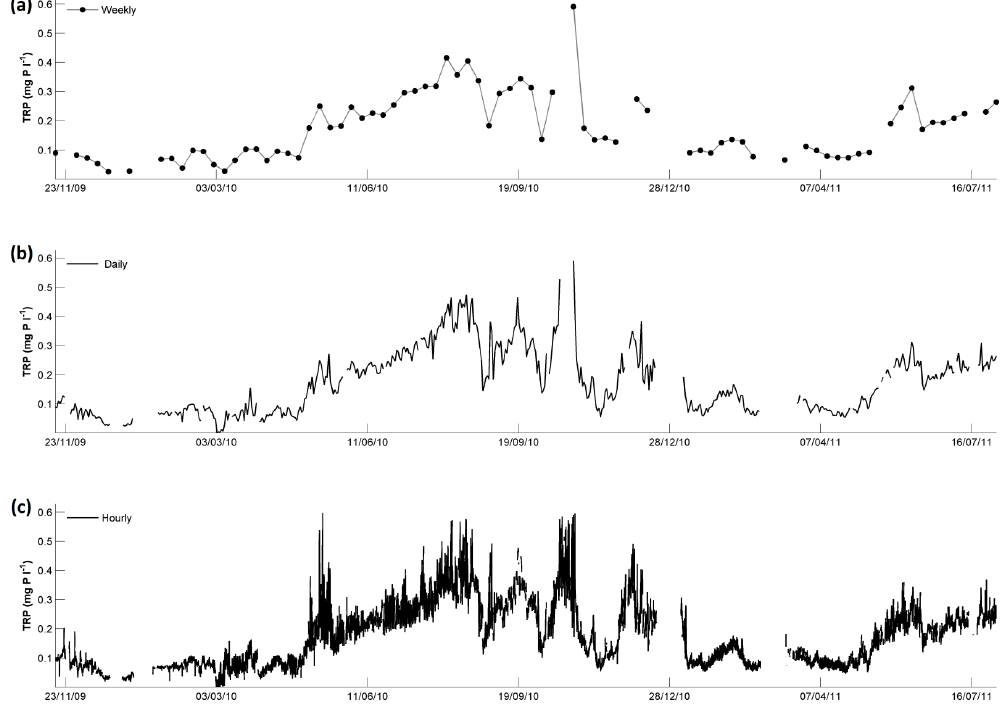
Figure 11 2 Fig. 11. Streamwater TRP concentrations, observed in the River Enborne, resampled onto lower frequencies to demonstrate the reduction information content as the sampling frequency decreases: (a) weekly, (b) daily and (c)